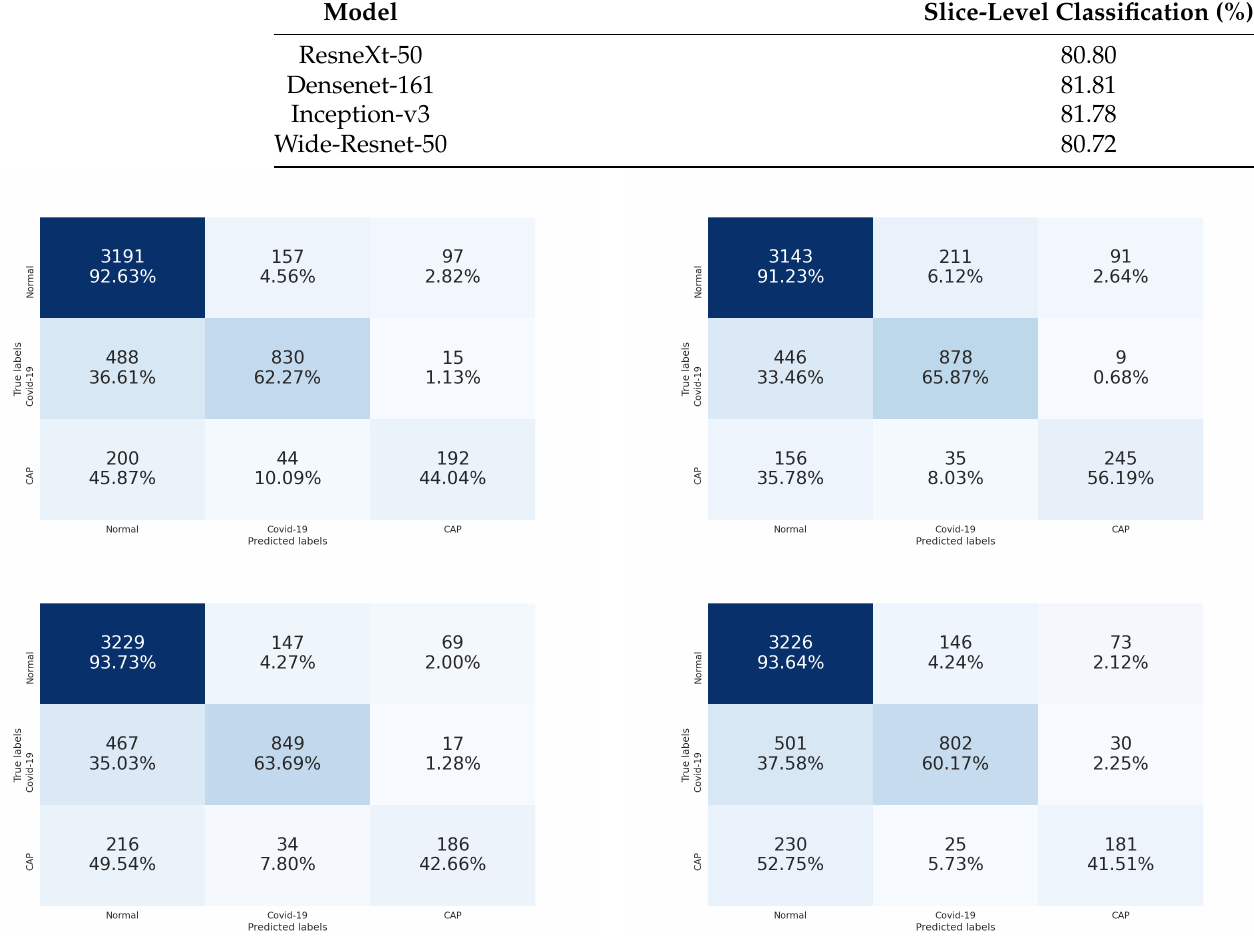
Table 1. Validation slice-level classification results using stacked grayscale images with four backbone